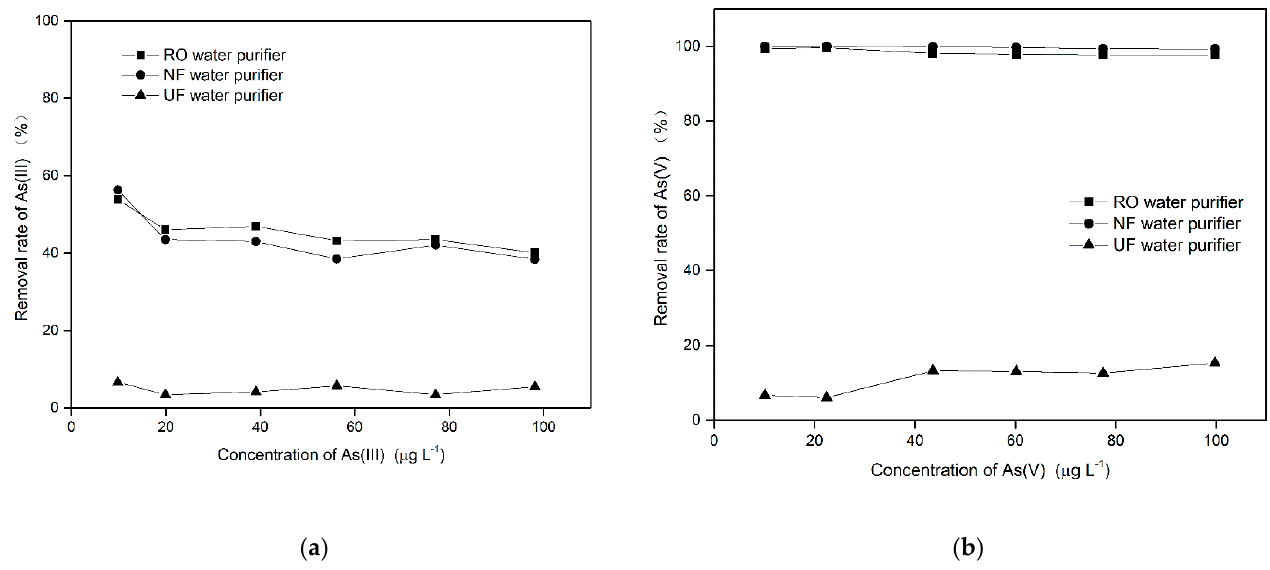
Figure 5. Removal efficiency of three types of water purifiers for ( a ) As(III) and ( b )